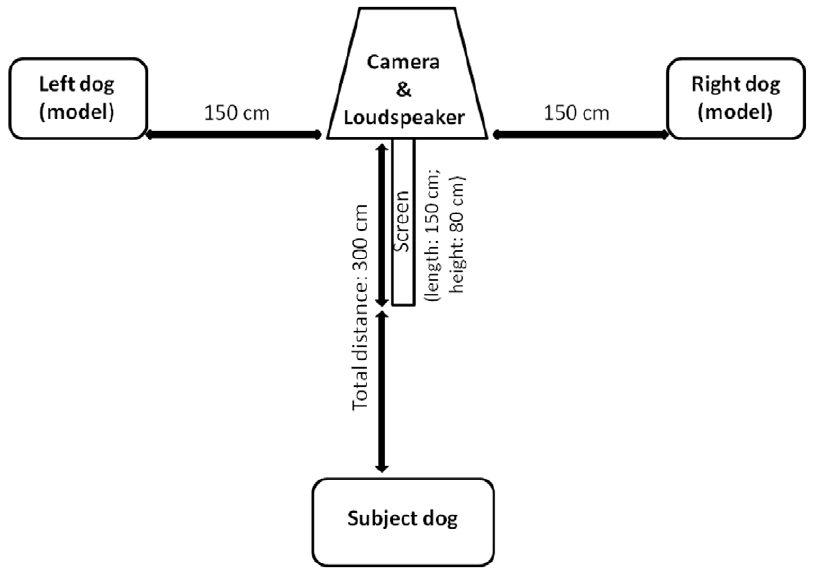
Figure 2. Experimental set-up, showing the layout of the testing area and distances between subject, models and loudspeaker.